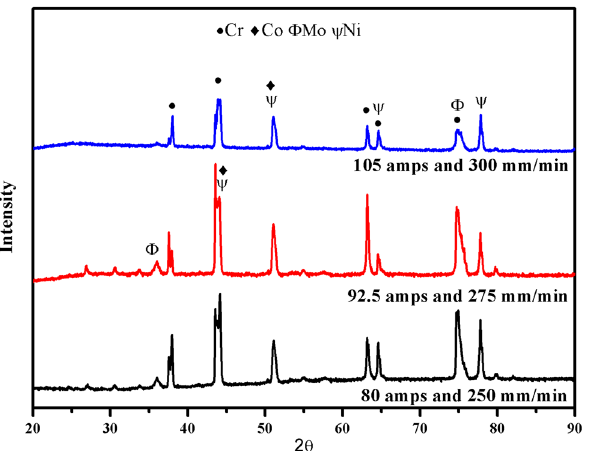
Figure 6: Micro - hardness of the Inconel 617 butt welded joints measured across the weld